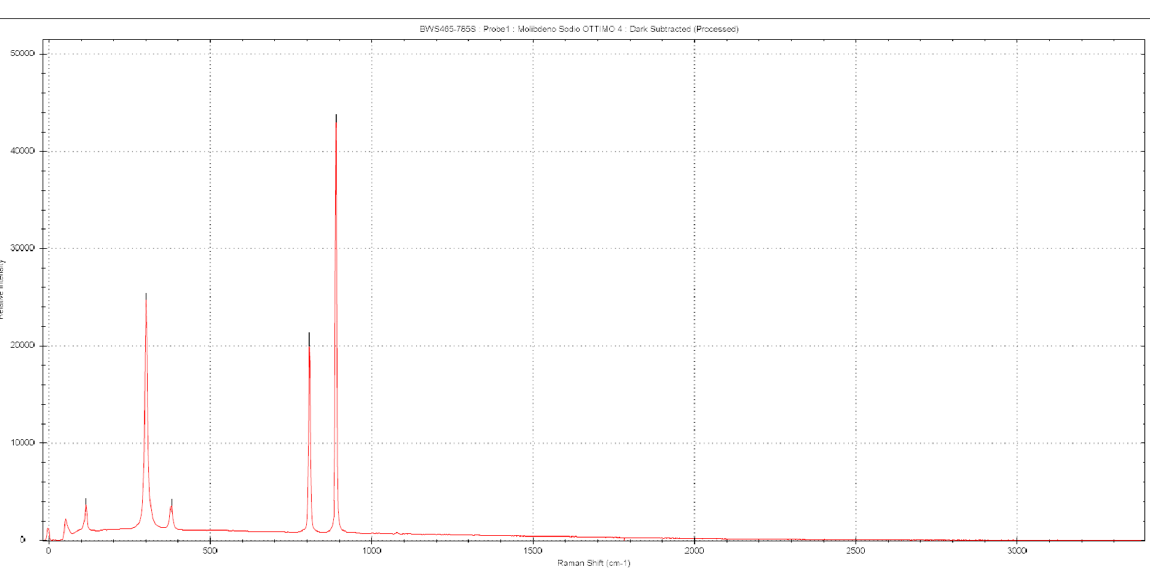
Figure 9. XRD pattern of sodium molybdate.